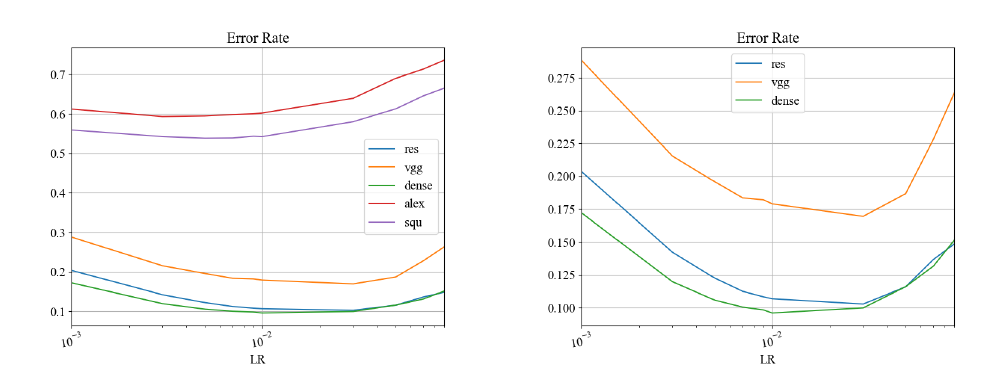
Figure 10. Compared performance of five DL networks for Classical kanji classification (Kuzushiji dataset rebalanced to ignore classes with fewer than 10 examples and cap the number of examples in a class to 200). Left , error rate (ER) results for all the DL networks considered. Right , details for the three best-performing